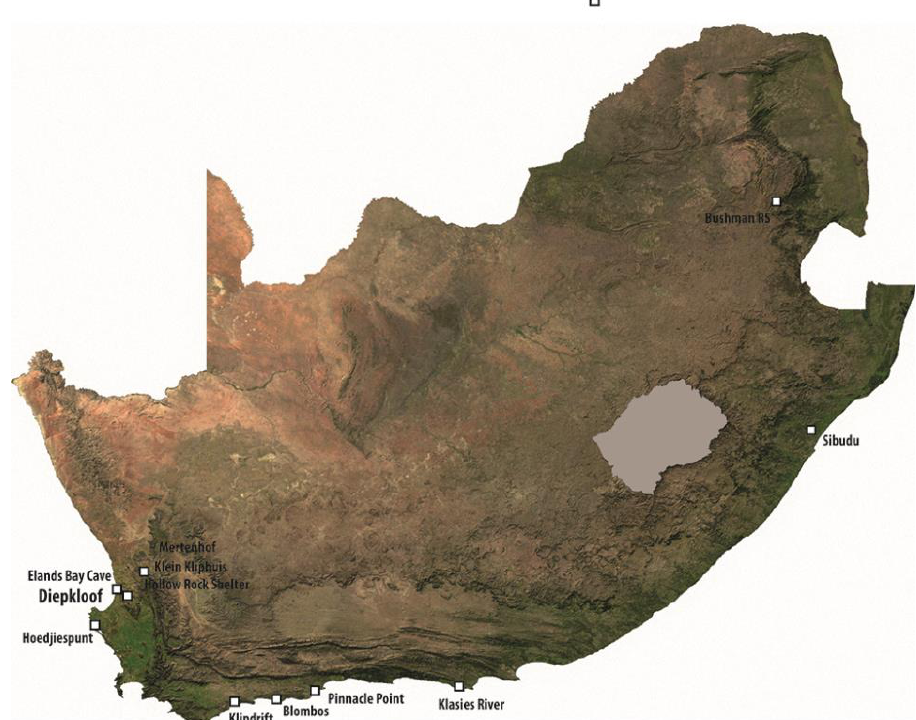
Figure 1. Map of South Africa with location of Diepkloof Rock Shelter and of the MSA sites mentioned in the text. A high resolution version of this figure is available at